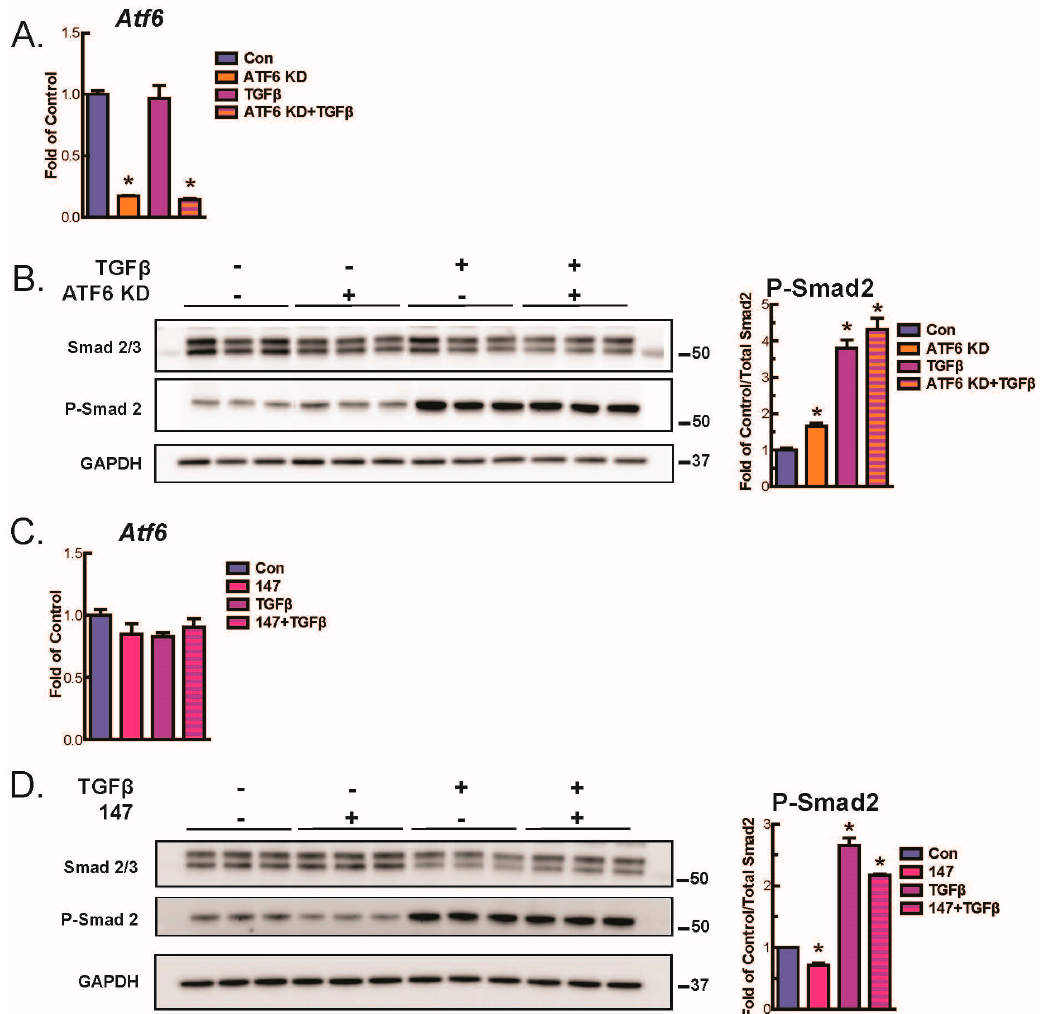
Figure 4. Immunoblots investigating activation of canonical TGF β signaling pathways. ( A ) AMVFs were treated with ± siRNA to ATF6, ± 10 ng / mL TGF β for 48 h. Atf6 knockdown is quantified via qPCR. ( B ) Immunoblotting for total Smad 2 / 3, P-Smad 2, or glyceraldehyde 3-phosphate dehydrogenase (GAPDH), with quantification of P-Smad 2 shown at right. ( C ) AMVFs were treated with ± 10 µ M compound 147, ± 10 ng / mL TGF β for 48 h. Atf6 levels were quantified via qPCR. ( D ) Immunoblotting for total Smad 2 / 3, P-Smad 2, or GAPDH, with quantification of P-Smad 2 shown at right. * p ≤ 0.05 by ANOVA. * Indicates significant difference between a condition and control according to Newman–Keuls post-test.